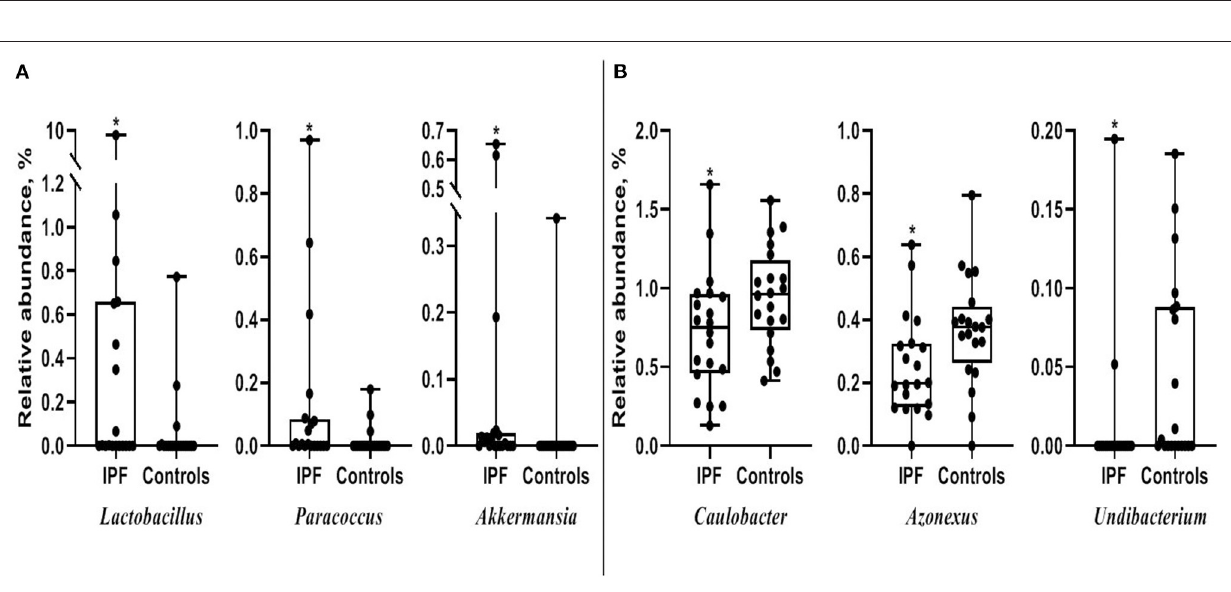
FIGURE 2 | Comparison of relative abundance between patients with IPF and controls. (A) Increased and (B) decreased in patients with IPF. The box plot shows the minimum, first quartile, median, third quartile, and maximum of relative abundance. * p < 0.05. IPF, idiopathic pulmonary